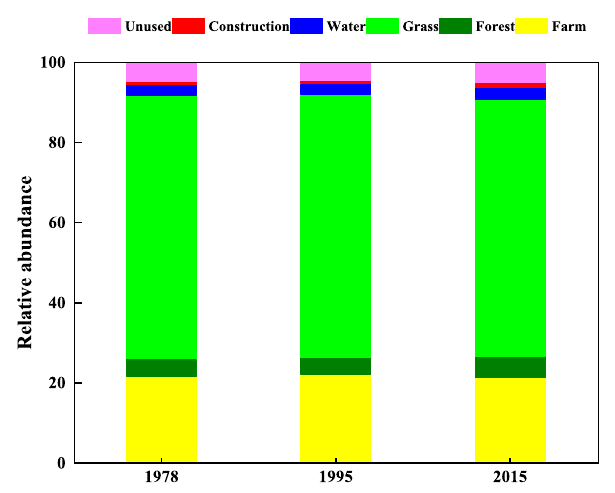
Fig. 7 Percent stacked column bar of land use in Huangfuchuan River basin in typical years